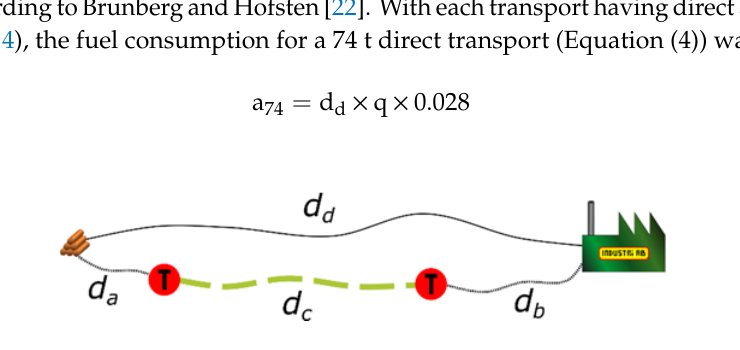
Figure 4. Schematic illustration of transport legs in a direct flow (dd) and a via ‐ corridor multiplex flow (da+dc+db).